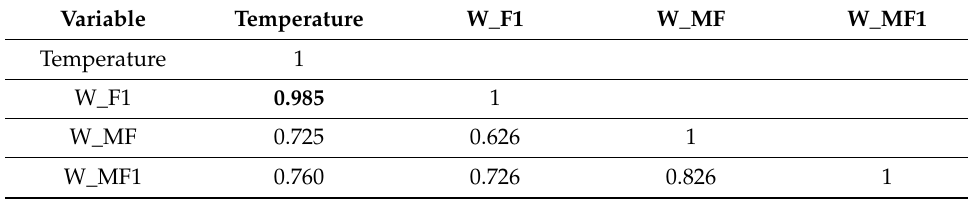
Table 3. Correlation matrix of CMC.